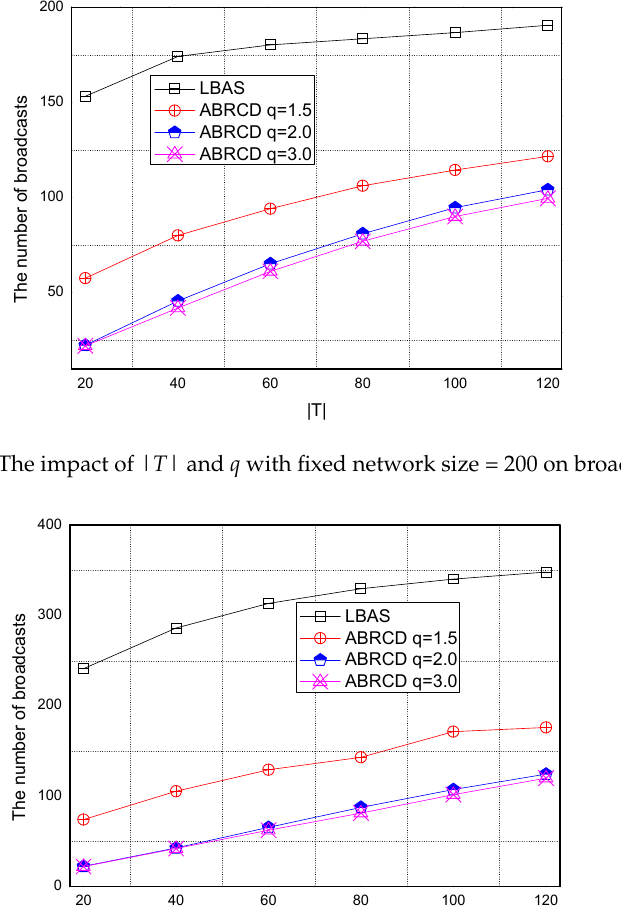
q LBAS ABRCD Figure 26. Energy utilization ratio with different q. 6. Experimental Results Analysis of the ABRCD Scheme 6.1. Transmissions Analysis